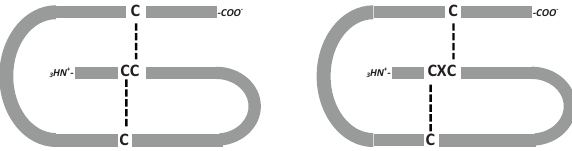
Fig. 1. Schematic representation of disulfide bridges between conserved cysteine residues (C) in the CC- and CXC- classes of